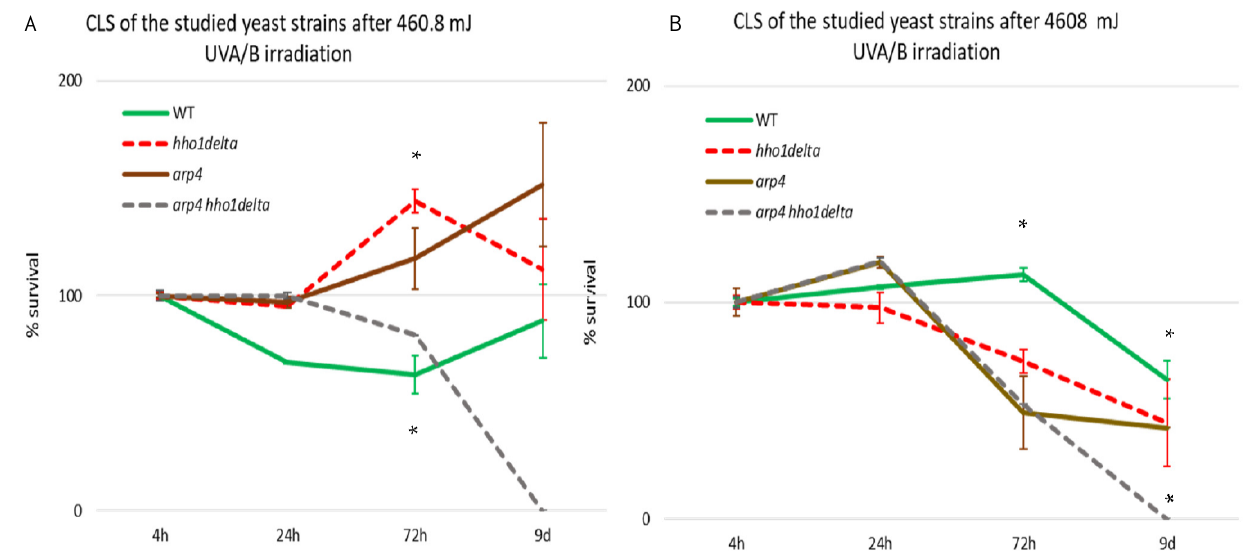
Figure 3. CLS of WT, hho1delta , arp4, and arp4 hho1delta yeast cells cultured for a period of 9 days after 3 and 30 min UVA/B irradiation. ( A ) CLS of the four studied strains after 3 min UVA/B irradiation (460.8 mJ). ( B ) CLS after 30 min UVA/B irradiation (4608 mJ). Cell survival in % is calculated for each of the four strains with the 4th hour of the WT accepted as 100% and the other cell survival time points were calculated as a percentage of it. Three repetitions of the experiment are done and results are presented as MEAN ± STDV. * designates p < 0.001.